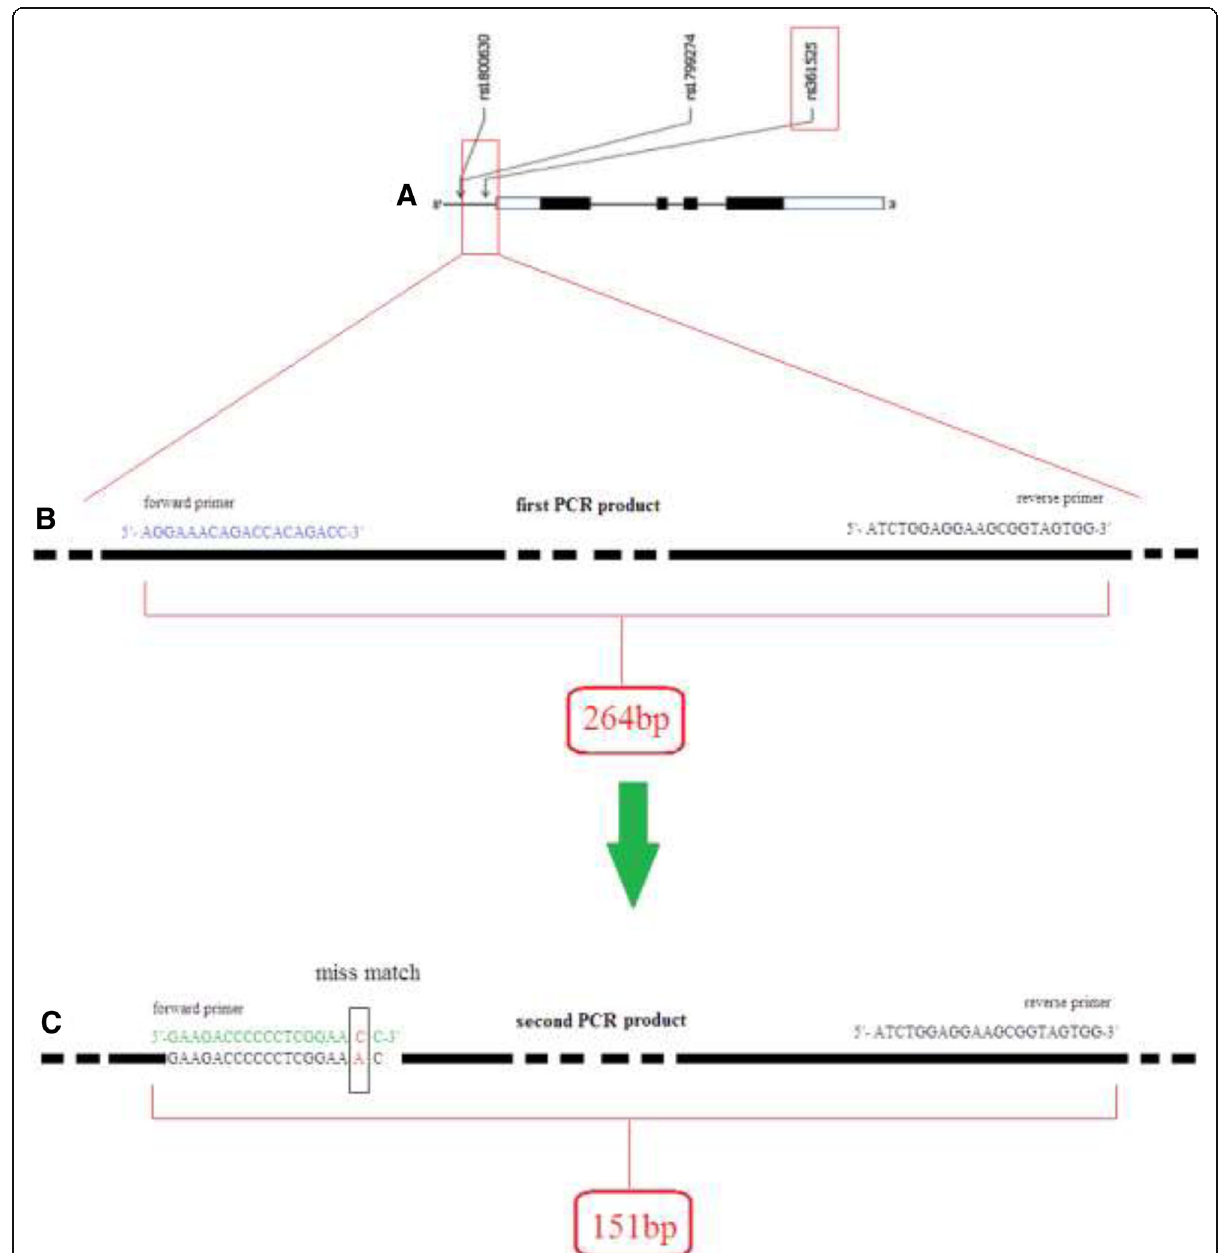
Fig. 1 a Gene map of a single-nucleotide polymorphism (SNP) in TNF- α gene on chromosome 6. Semi-nested PCR with two pairs of primers. The reverse primer was common for both PCRs. b Primers and PCR product size in the first PCR. c Primers and PCR product size in the second PCR (semi-nested). (TNF- α : tumor necrosis factor- α